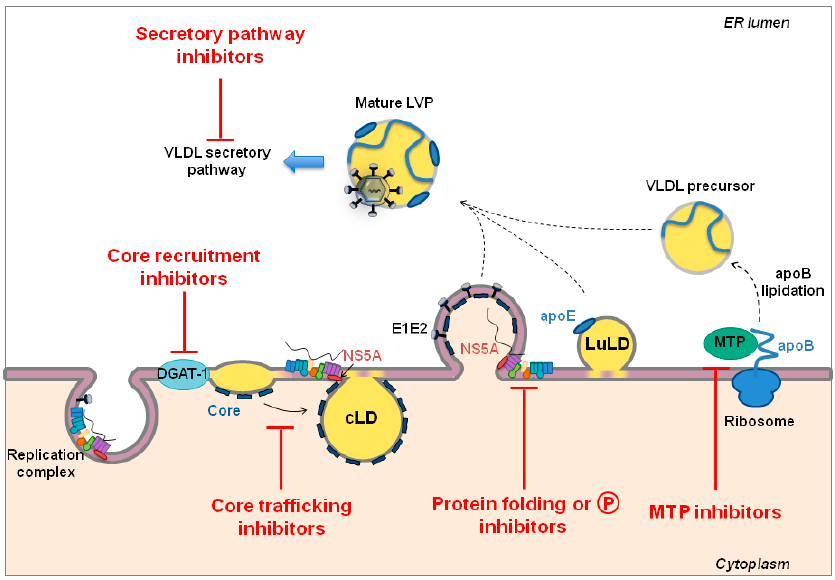
Figure 3. Schematic representation of HCV assembly. Virion assembly is triggered by core recruitment on cytosolic lipid droplets (cLDs) by the diacylglycerol acyltransferase-1